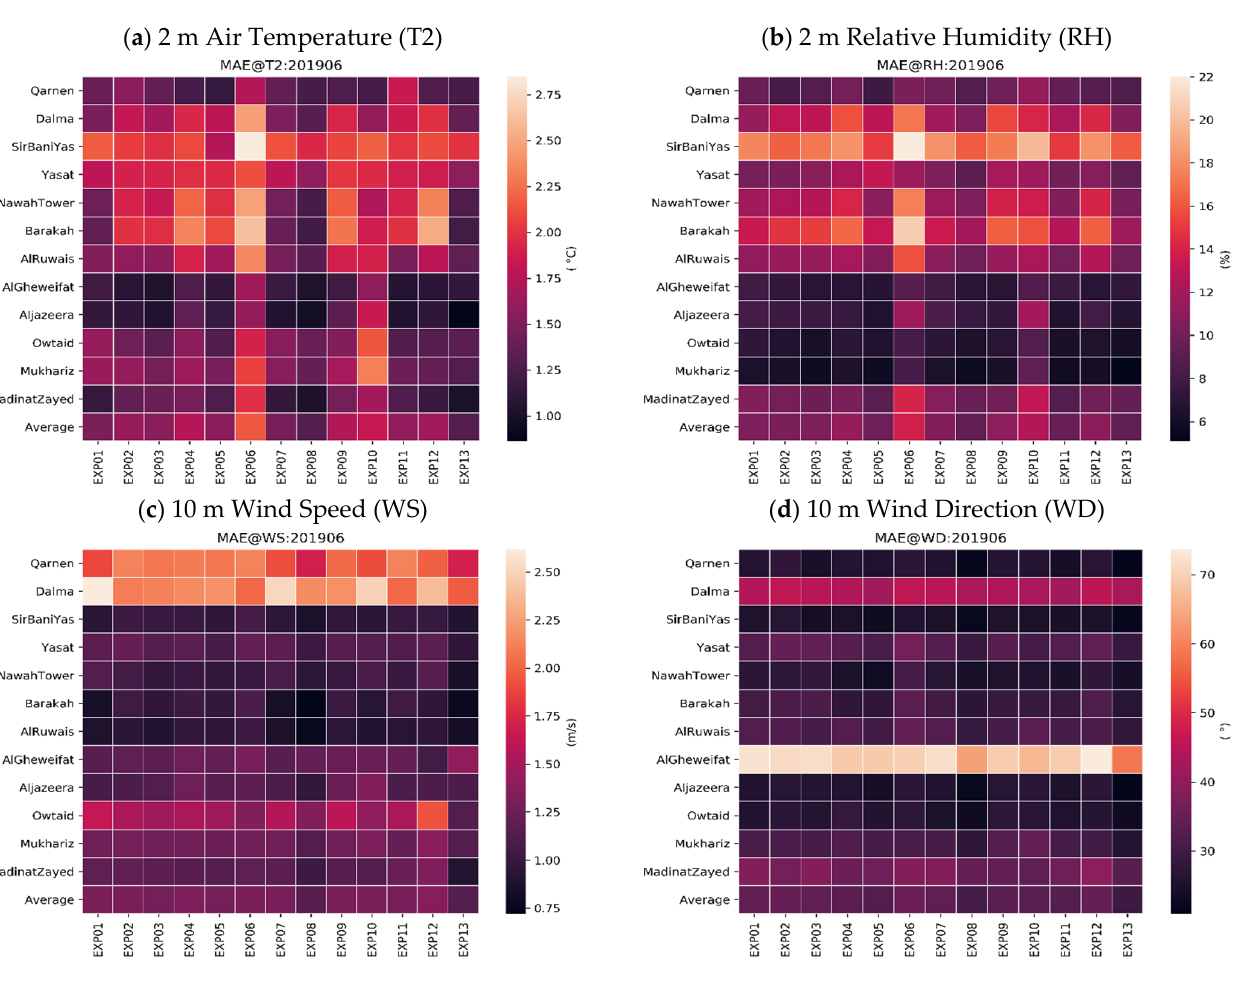
Figure 4. Mean Absolute Error ( MAE ) between station data and the conducted model experiments calculated using June 2019 hourly data for the surface parameters 2m air temperature (T2) and relative humidity (RH), wind speed (WS), and wind direction (WD) at 10 m above the ground. The last lines of the heatmaps show average values over all stations.